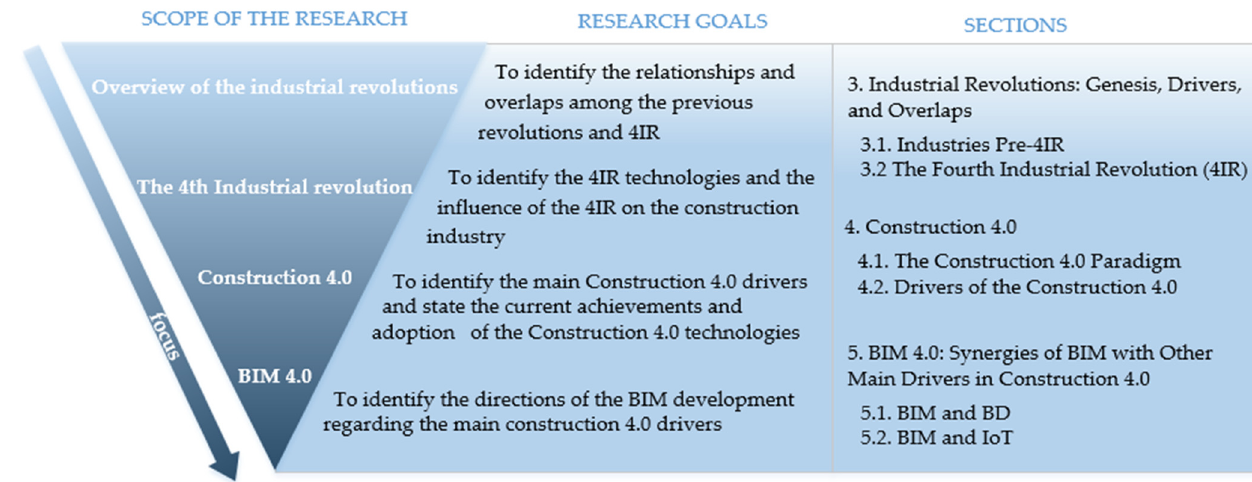
Figure 1. The scope of the research, research goals, and sections.